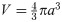
Model for the merging of bacterial clusters.Each spherical cluster consists of a certain number of gonococci and is characterized by its radius a and volume V=43πa3. The two sketched aggregates merge after an exponentially distributed waiting time, if the corresponding pili shells of the width l
0 overlap. After aggregation, the total volume of cells is conserved (see also the explanation in the text). Note that the extent of the actual mixing of cells from two different clusters is not known and here should be only considered as an illustration.